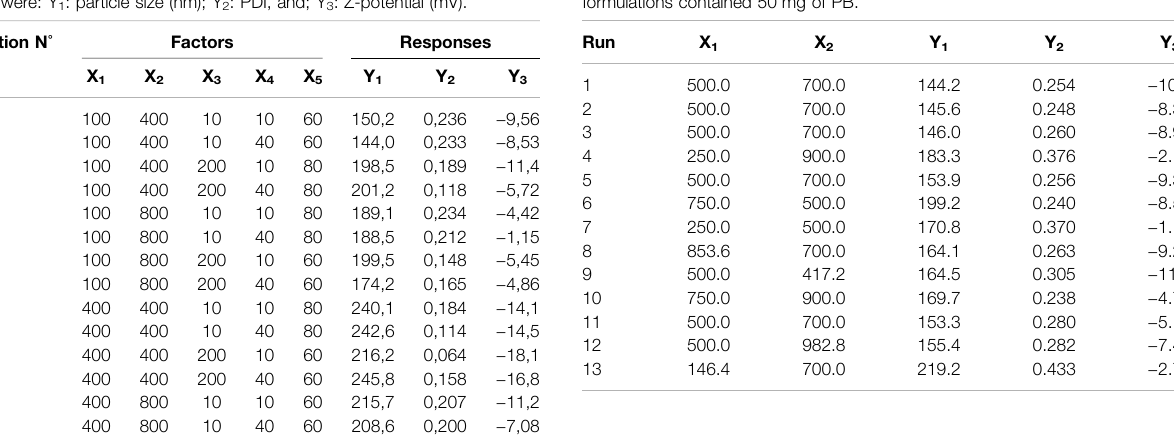
TABLE 2 | Factors (X), levels, and measured variables (Y) corresponding to the central composite or optimization design: formulations were synthesized according to the created design. Independent variables considered were: X 1 : the amount of solid lipid (mg) and X 2 : amount of surfactant (mg). Dependent